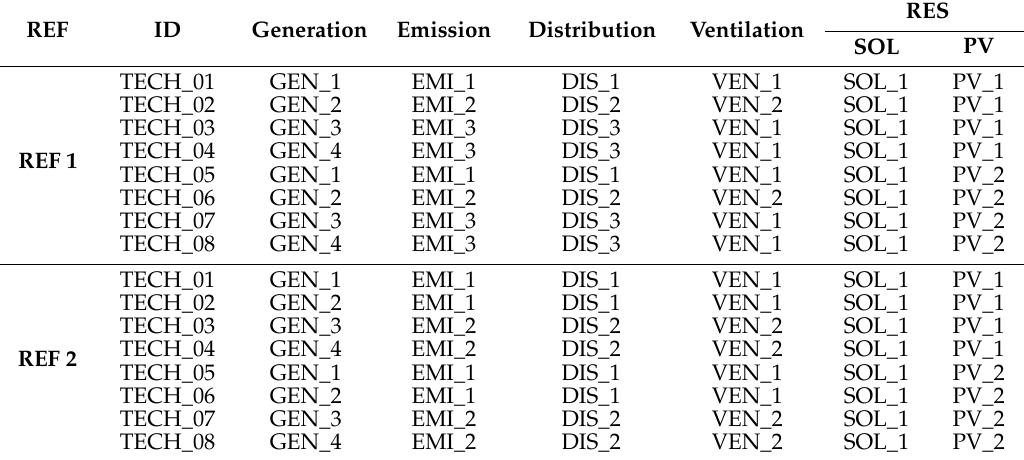
Table 6. Combination of technical